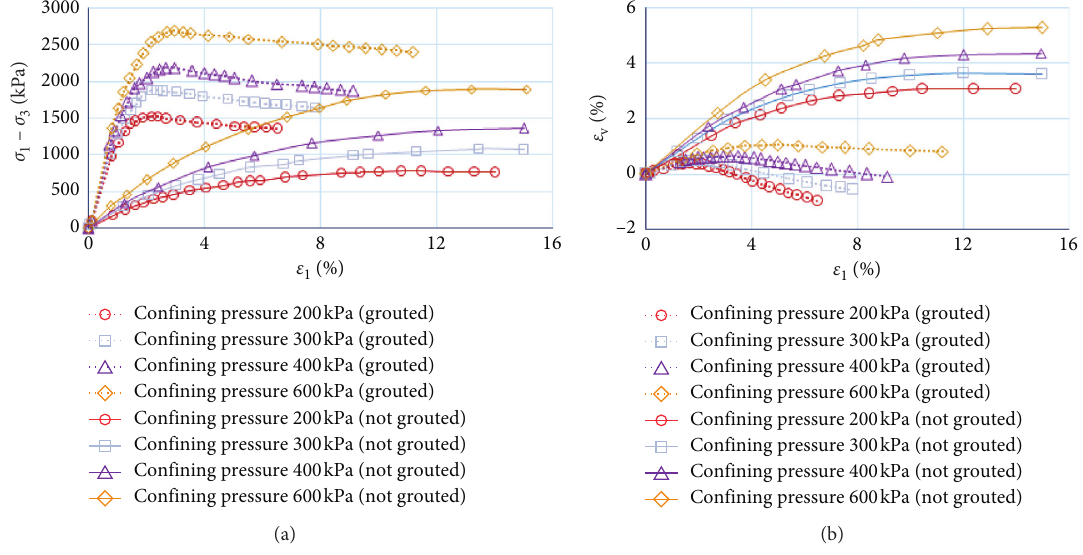
Figure 9: Relationship curves of the deviatoric stress and body strain with the axial strain of rockfill materials with average gradation in the triaxial shear test before and after grouting reinforcement. (a) Deviatoric stress. (b) Body